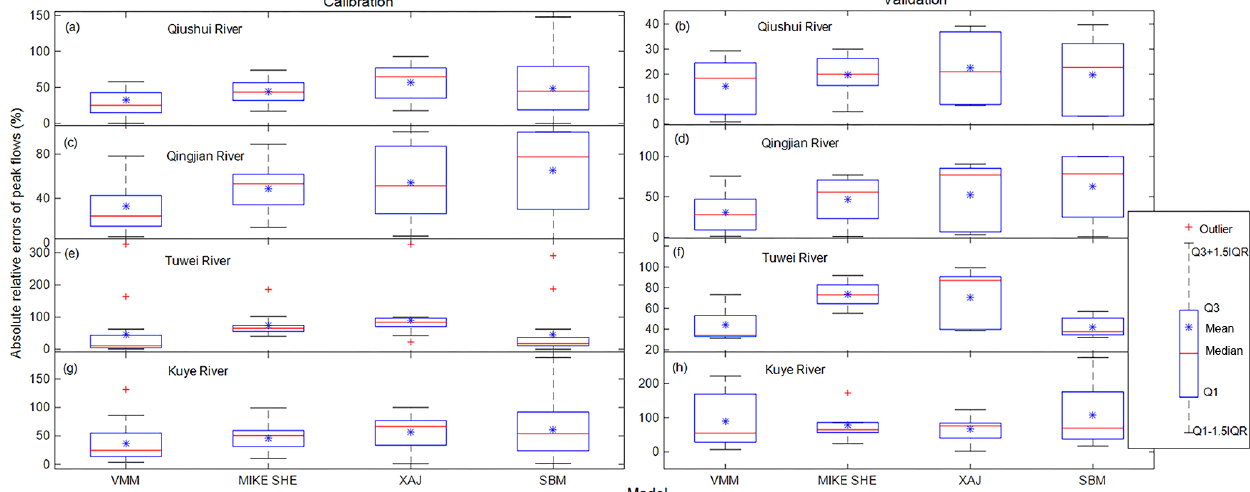
Figure 3. Boxplot of absolute relative errors of peak flows in the four catchments. Q 1 and Q 3 represent the 1st quantile and 3rd quantile, respectively; interquartile range IQR = Q 3 − Q 1 . An outlier is defined as an extreme value that exceeds the range of Q 1 − 1 . 5IQR and Q 3 + 1 . 5IQR.